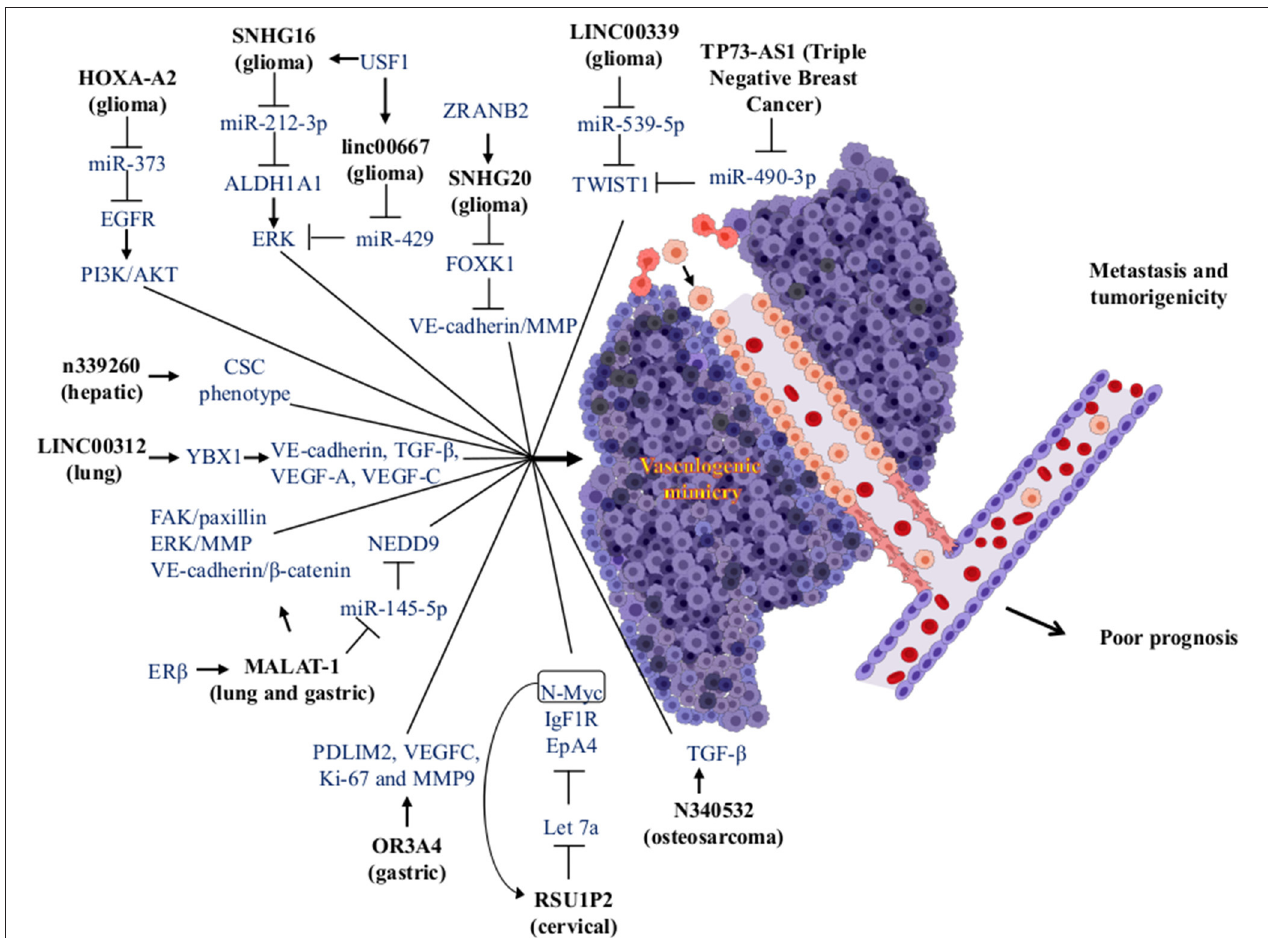
FIGURE 4 | Modulation of miRNAs and lncRNAs associated with VM formation. The lncRNAs (bold letters) can interact with miRNAs or proteins, impacting various signaling pathways, which in turn trigger the formation of VM structures in tumors. The VM has been associated with an increase in metastasis and tumorigenicity, being factors that cause a poor prognosis in cancer patients. Created with Biorender.com.